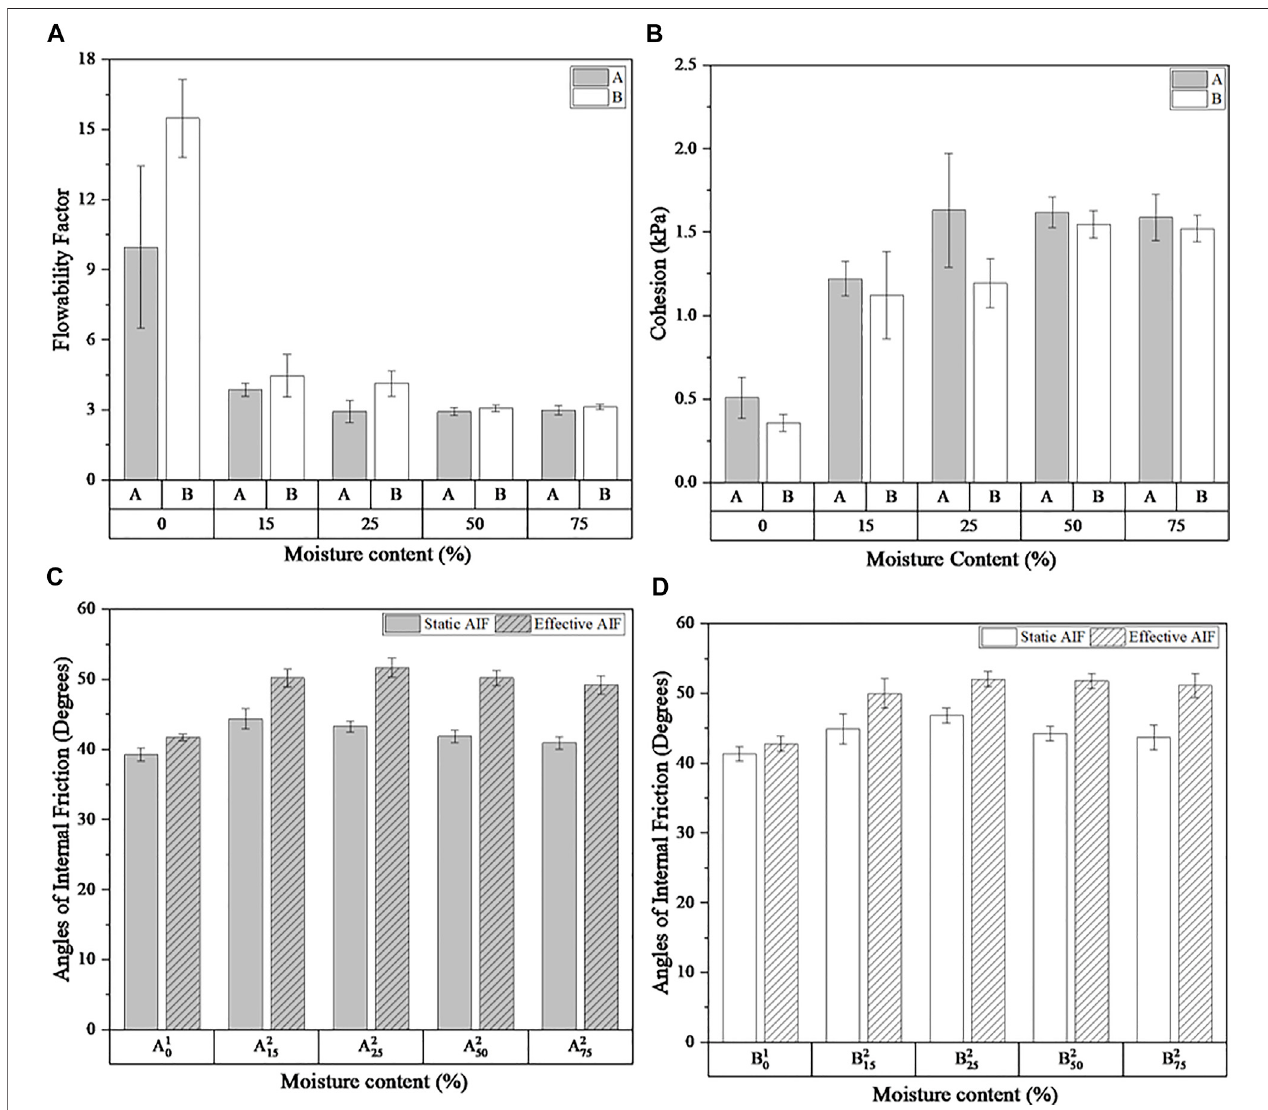
FIGURE4| Shear testresults for A and B . (A) Flowabilityfactor for A and B at 0,15, 25,50, and 75%moisture contents. (B) Cohesionfor A and B at0, 15,25, 50, and75%moisturecontents. (C) Staticandeffectiveanglesofinternalfrictionof A with0,15,25,50,and75%moisturecontents. (D) Staticandeffectiveanglesofinternal friction of B with 0, 15, 25, 50, and 75% moisture contents. Data points were obtained from steps A 1 0 , A 2 x , B 1 0 , and B 2 x .